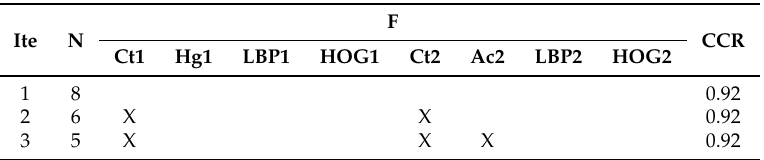
Table 9. Inter-modal selection. Correct classification rates obtained when applying the proposed selection process on breast MRI and DECEDM selected texture features. Ite: iteration. N: number of features kept. F: features. CCR: correct recognition rate.